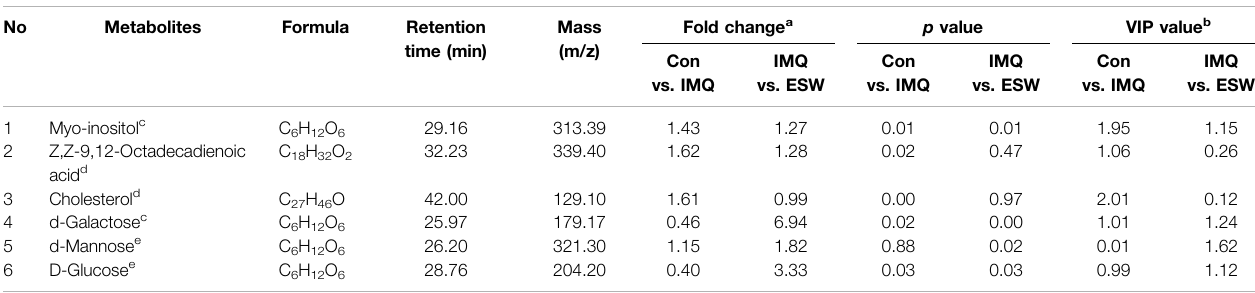
TABLE 3 | Summary of potential metabolites in the